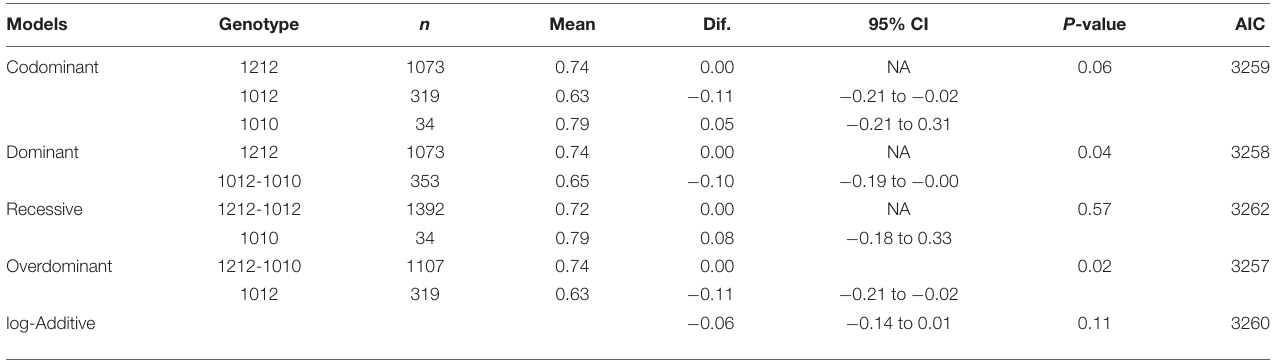
TABLE 3 | After stratification for the STin2 genotypes, the association of HTTLPR polymorphism with the F2 question in the Fagerström Test for Nicotine Dependence, “Do you find it difficult to refrain from smoking in places where it is forbidden?” became more significant. Models